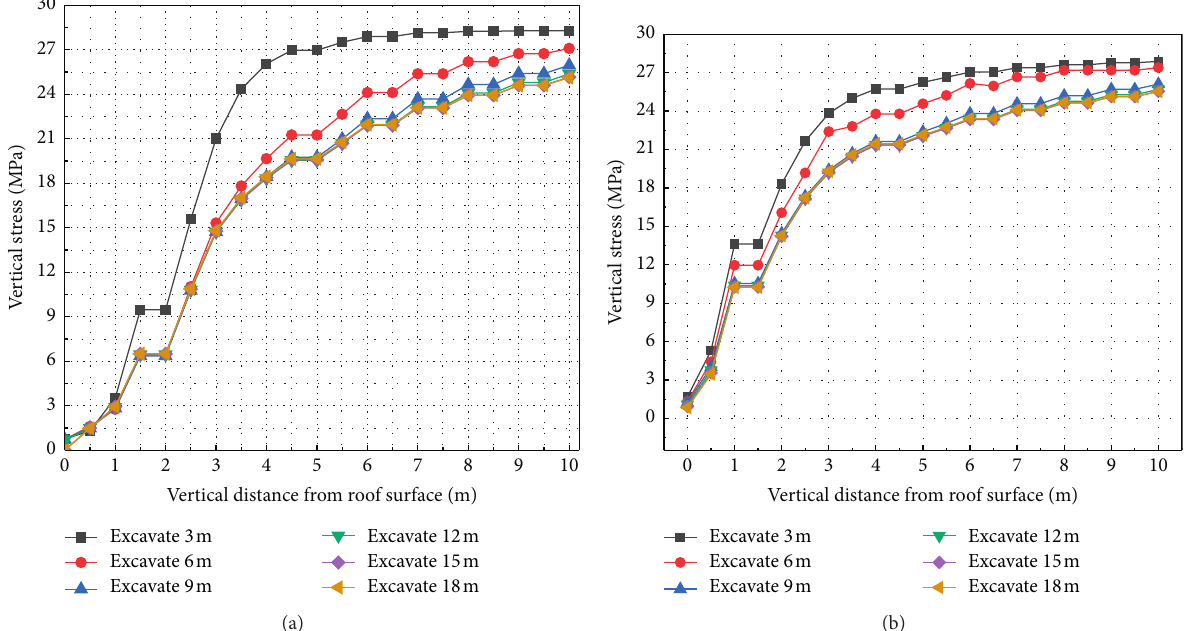
Figure 10: Vertical stress evolution under different excavation distance without and with surrounding rock grouting. (a) Without surrounding rock grouting. (b) With surrounding rock grouting.